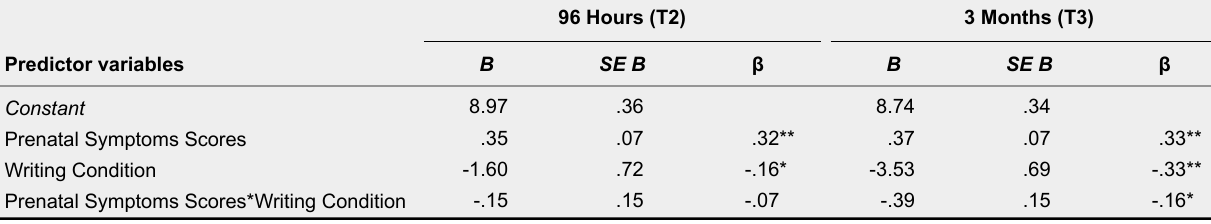
Regression Analysis Predicting Depression Scores at 96 Hours (T2) and at 3 Months